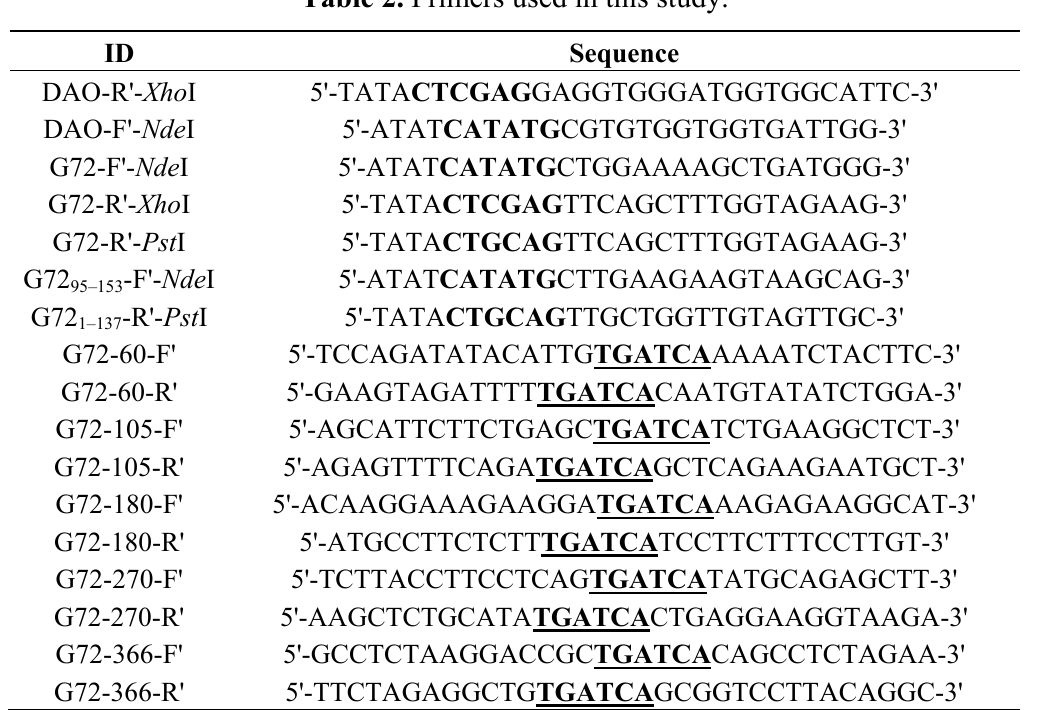
Table 2. Primers used in this